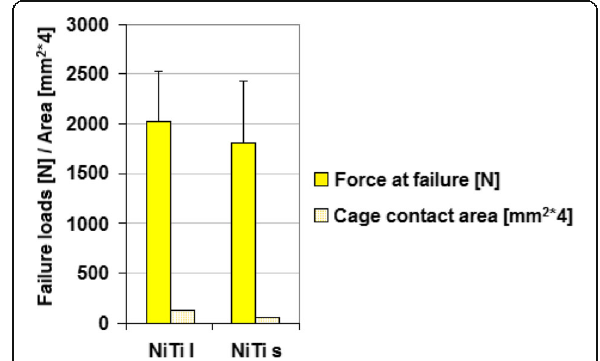
Fig. 6 Maximum force together with cage contact area (means and standard